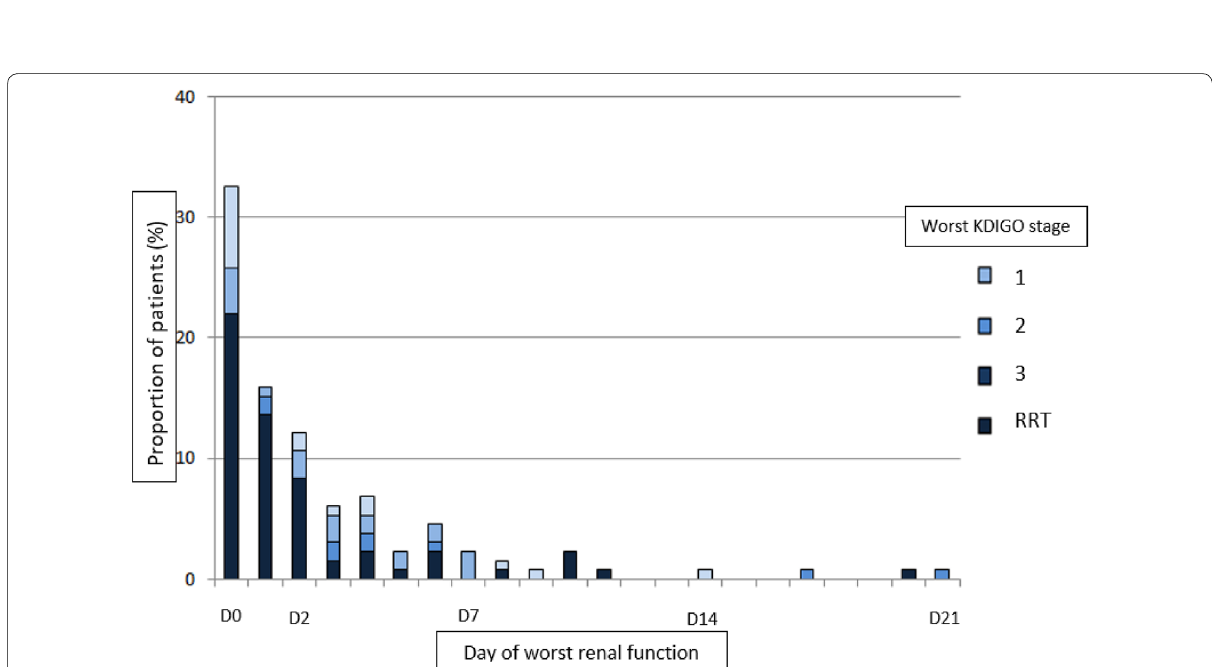
Fig. 3 Day of worst renal function. KDIGO Kidney Disease Improving Global Outcome, RRT renal replacement